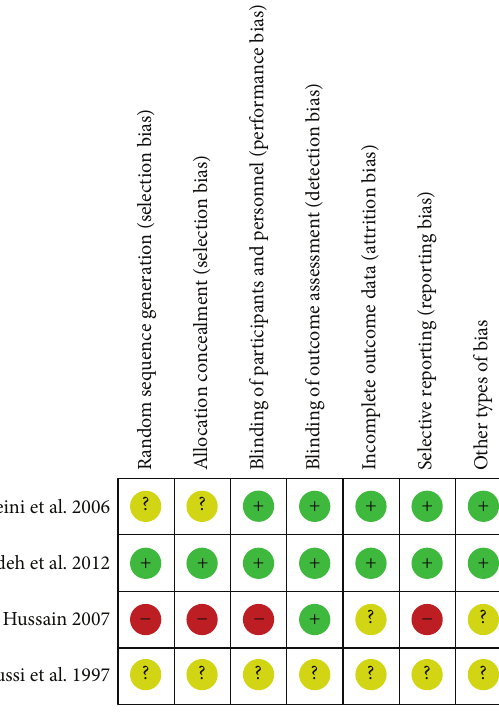
Figure 3: Risk of bias summary: review authors’ judgments about each risk of bias item for each included